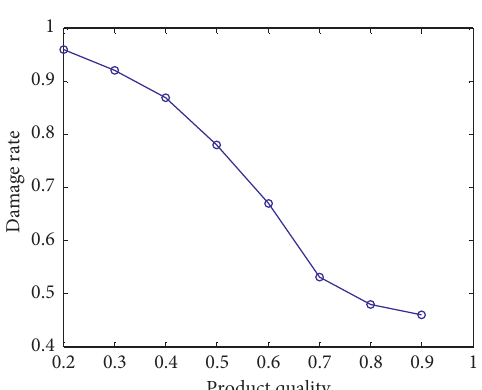
Figure 9: Relationship between product quality table and damage rate. Figure 10: Product quality and damage rate